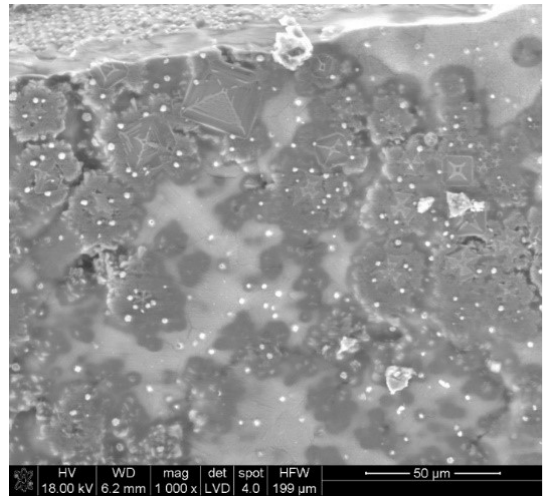
Figure 9. SEM-EDX sample identified as CuSin3.